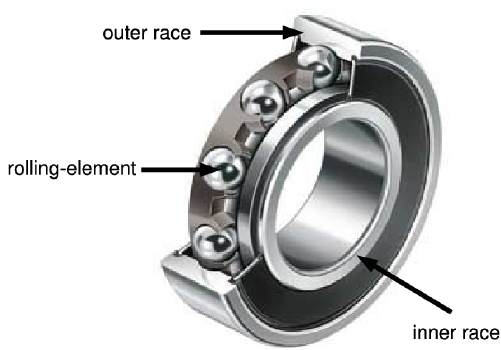
Figure 4. Critical components of the train motor [49].